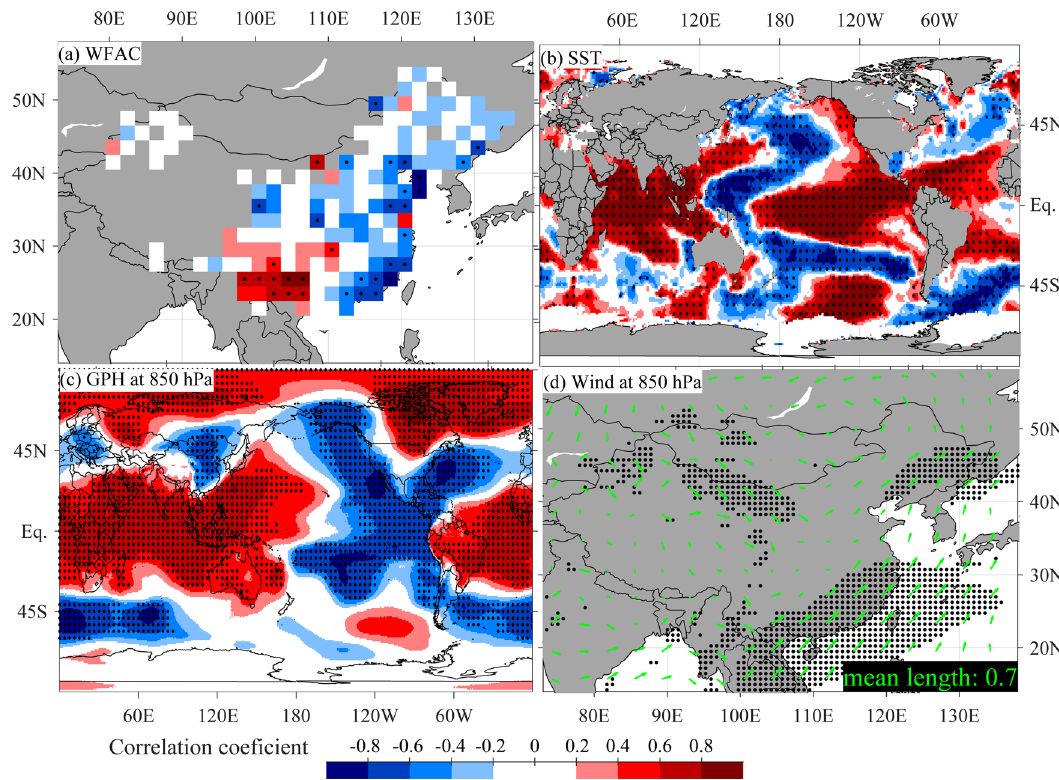
Fig. 5 Relationships between the leading coupled fi re and oceanic and atmospheric patterns. Homogeneous correlation maps of the fi rst leading singular value decomposition (SVD) between Wild fi re Atlas of China (WFAC) and global sea surface temperature (SST) for the a WFAC and b SST. Correlations of the left singular vector (WFAC) of the fi rst leading SVD mode with c the geopotential heights (GPH) and d the horizontal winds at 850 hPa. The SVD and correlations analyses are calculated between the fi rst-differenced data during the main fi re season January to April. Black dots denote that the signi fi cance level is above α = 0.05. In d , the arrows ’ projections on the x - and y -axes denote the correlations with zonal and meridional winds, respectively; and the black dots denote that at least one of the correlations is above the signi fi cance